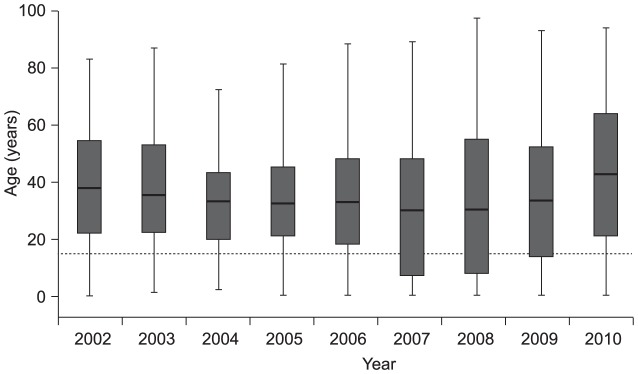
Distribution of reported hospitalized dengue disease cases according to age, Brazil, 2002–2010.A reduction in the first quartile of dengue disease hospitalizations is evident in 2007–2008, although data from 2009 suggest this change may have been transient. Data are median, first and third quartiles, and minimum and maximum ages; the dashed line indicates age 15 years. (Siqueira 2010 [26]. Figure updated and reproduced with kind permission from the Secretariat of Health Surveillance (SVS) of the Ministry of Health of Brazil; additional data supplied by Siqueira JB, 2012).